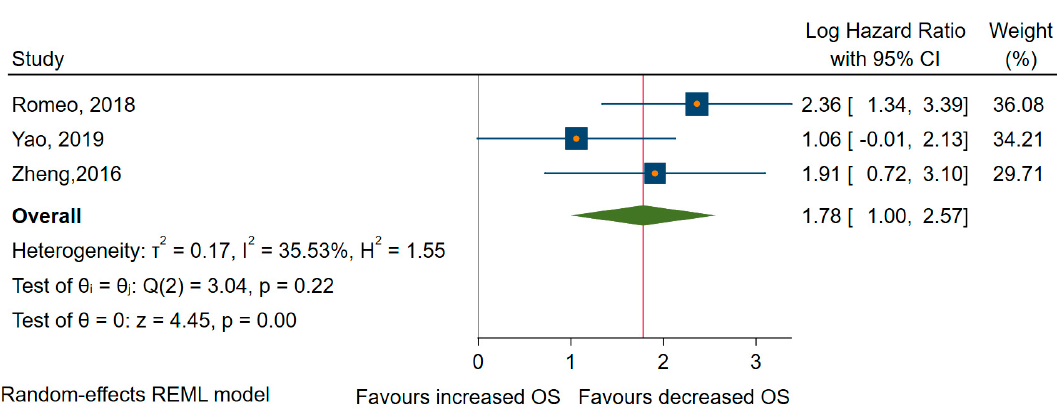
16 of 30 Figure 5. Forest plot of the association between the upregulated miRNAs and DFS/RFS.